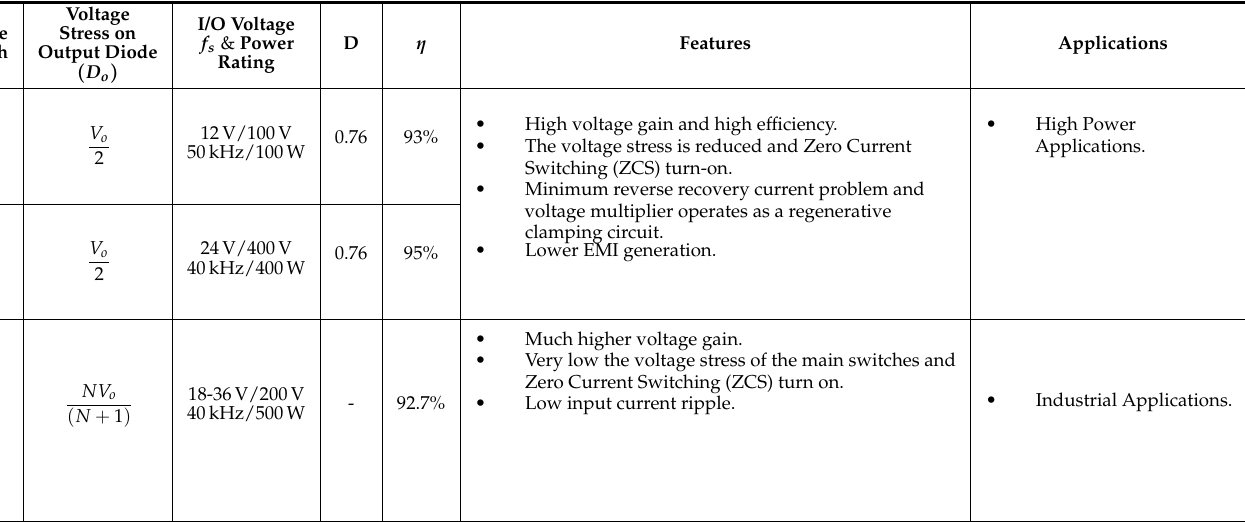
Table 6. Comparison of Voltage Multiplier (VM)